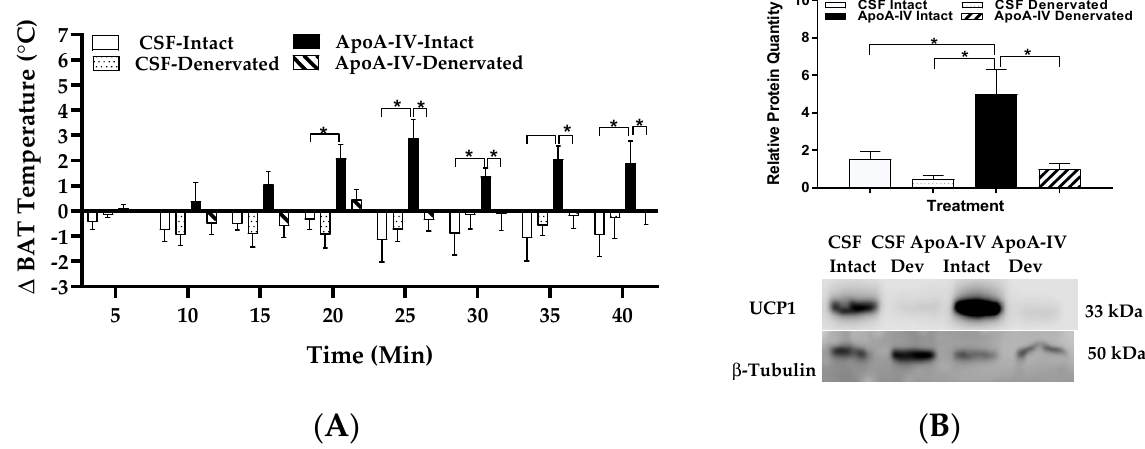
Figure 4. The effect of ApoA-IV on BAT temperature and UCP1 protein levels in mice with unilateral denervation of BAT. BAT temperature in intact and denervated BAT was measured every 5 min for up to 40 min in mice following administration of either ApoA-IV (n = 6–7/dose group) or CSF ( A ). Mice with unilateral denervation of BAT received central administration of either CSF (1 µ L) or ApoA-IV (12 µ g) into the third ventricle and BAT was collected at 40 min post-injection. UCP1 in BAT was measured by immunoblot analysis ( B ). Data are expressed as the means ± SEM for 5–6 mice per group. * Represents a significant difference relative to CSF-treated BAT ( p < 0.05).